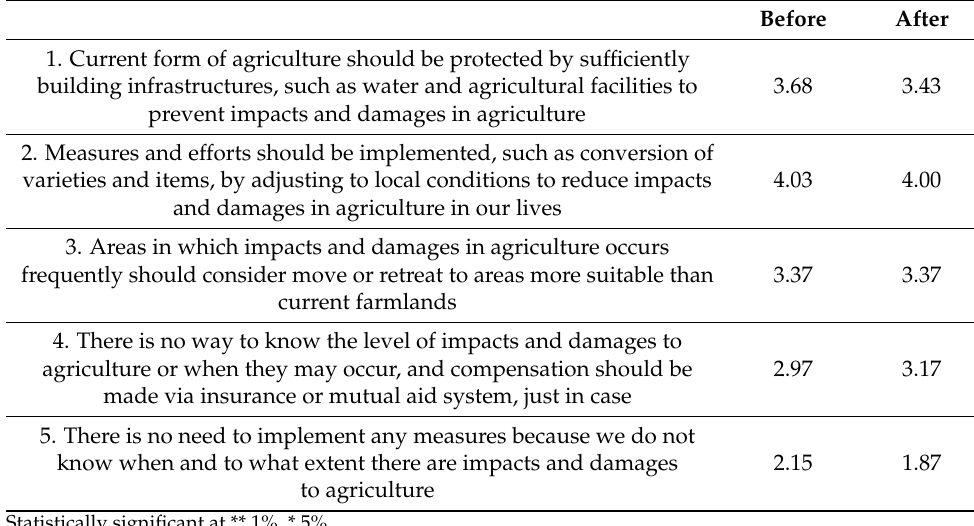
Table 8. Pros and cons of climate change adaptation policies in agriculture and rural areas.